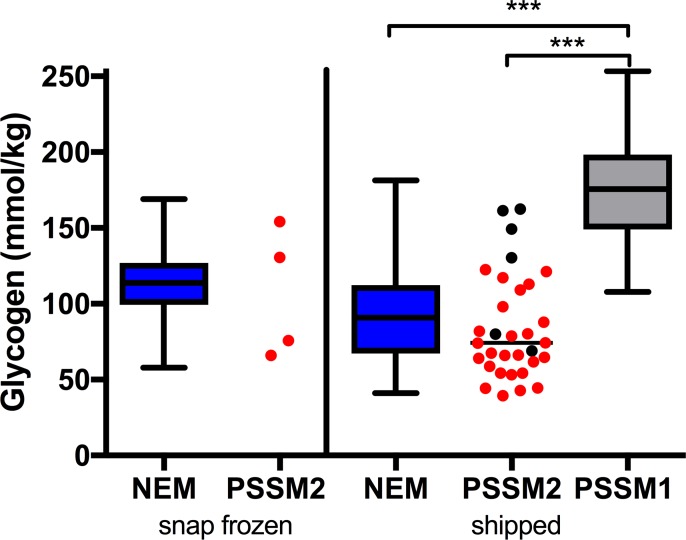
Skeletal muscle glycogen concentrations.Box and whisker plots indicate minimum to maximum values for snap frozen and shipped samples of control horses that had no evidence of a myopathy (NEM), type 1 PSSM (PSSM1), and individual values are shown for PSSM2. Black circles indicate euthanized WB horses. Glycogen concentrations were not different between PSSM2 WB and NM. PSSM1 glycogen concentrations were significantly higher than PSSM2 WB and NM horses (p < 0.0001).